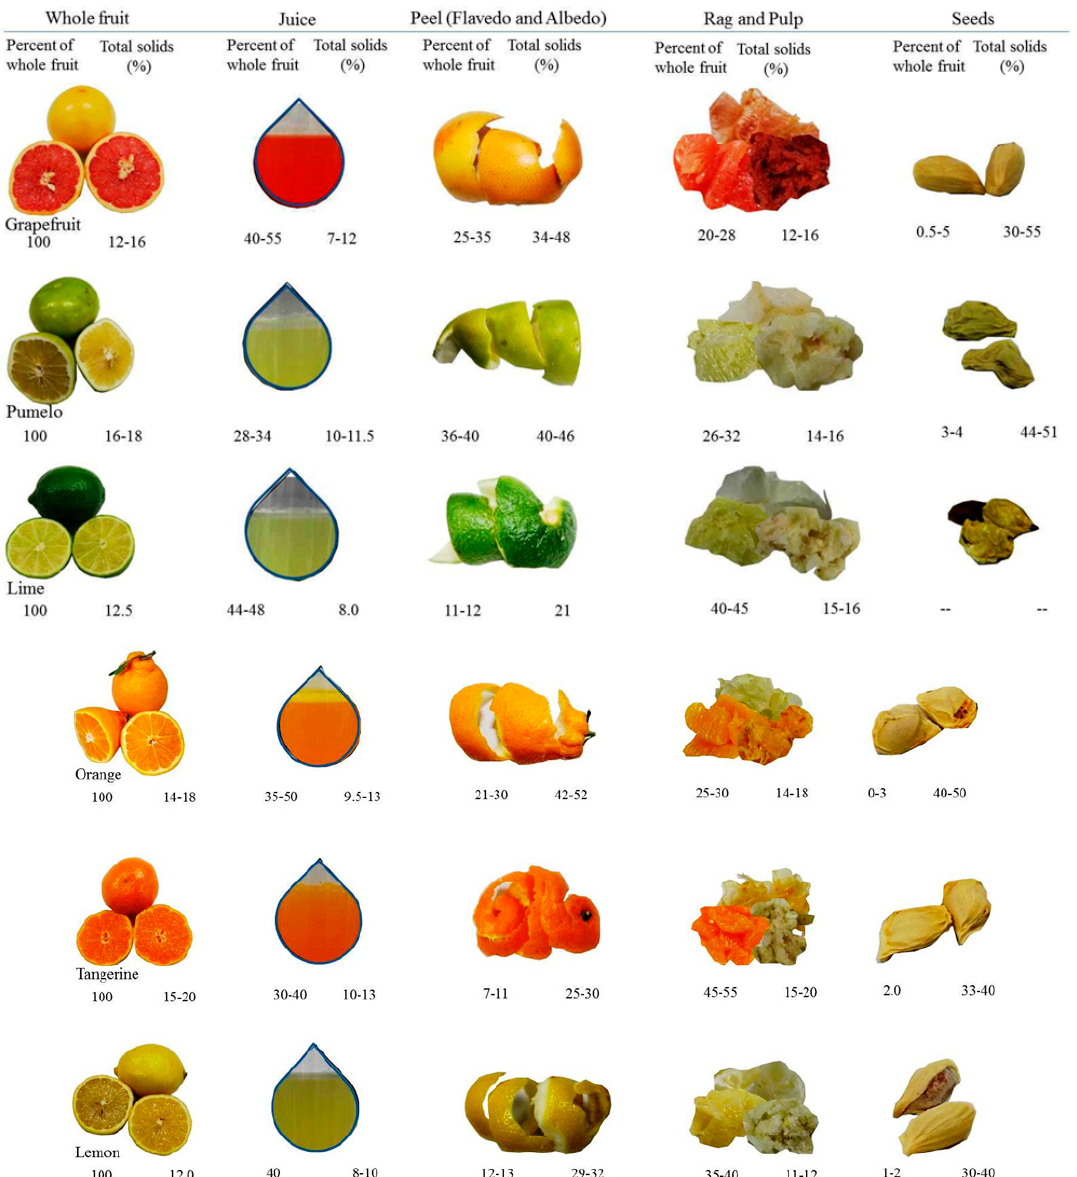
Figure 2. The main citrus varieties and its physical composition in terms of edible juice and inedible waste part, which consists of peel (flavedo and albedo), rags (pith, pulp residue, and segment membrane), and seeds [10,13,21] .